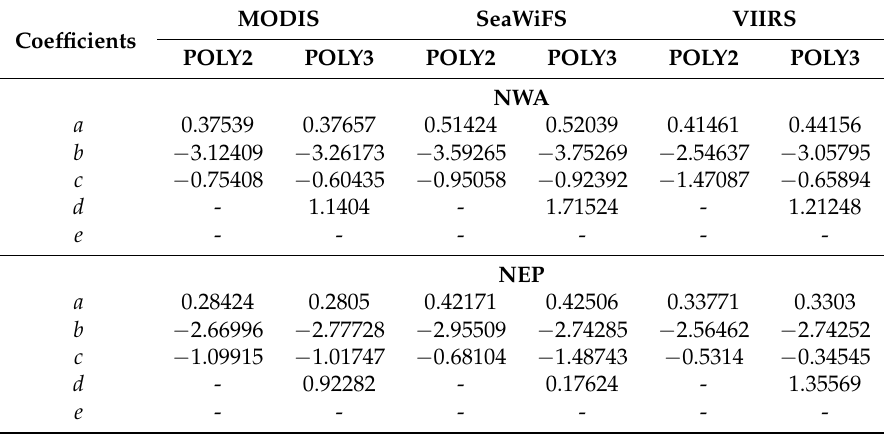
Table A7. Coefficients of the remaining OCx algorithms for each sensor and